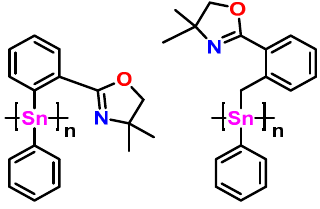
Figure 3. Target tin oxazoline polymers.